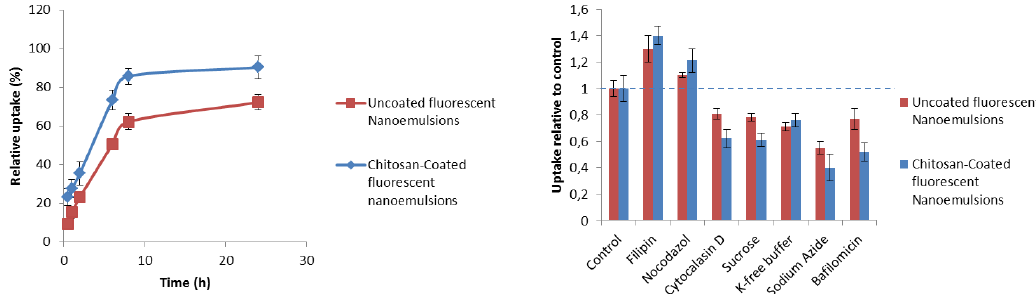
Figure 4. Left , overall cellular uptake quantification of H9c2 cells (at a density of 5 × 10 3 cells/well) from 0.5 up to 24 h of contact with fluorescent nanocarriers at 1% v / v oil. Right , effect of different inhibitors on the internalization of fluorescent nanocarriers (1% v / v oil) in H9c2 cells after 4 h of incubation. The data are normalized against their controls.